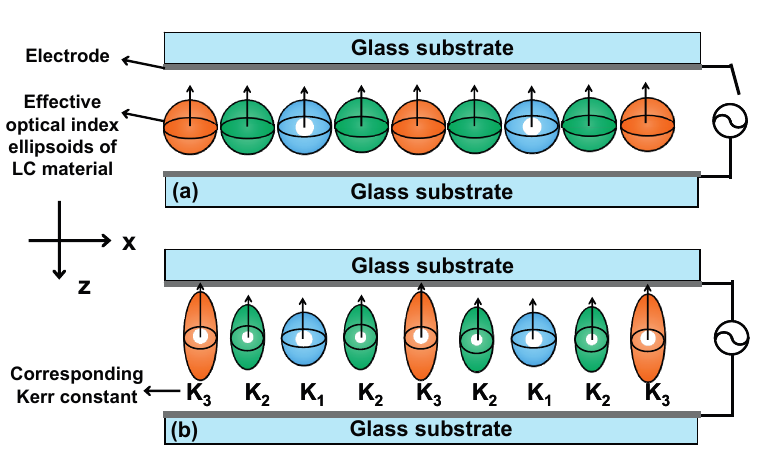
Figure 1. The structure and operating principles of the LC (liquid crystal) microlens arrays ( a ) without an applied voltage and ( b ) with an applied